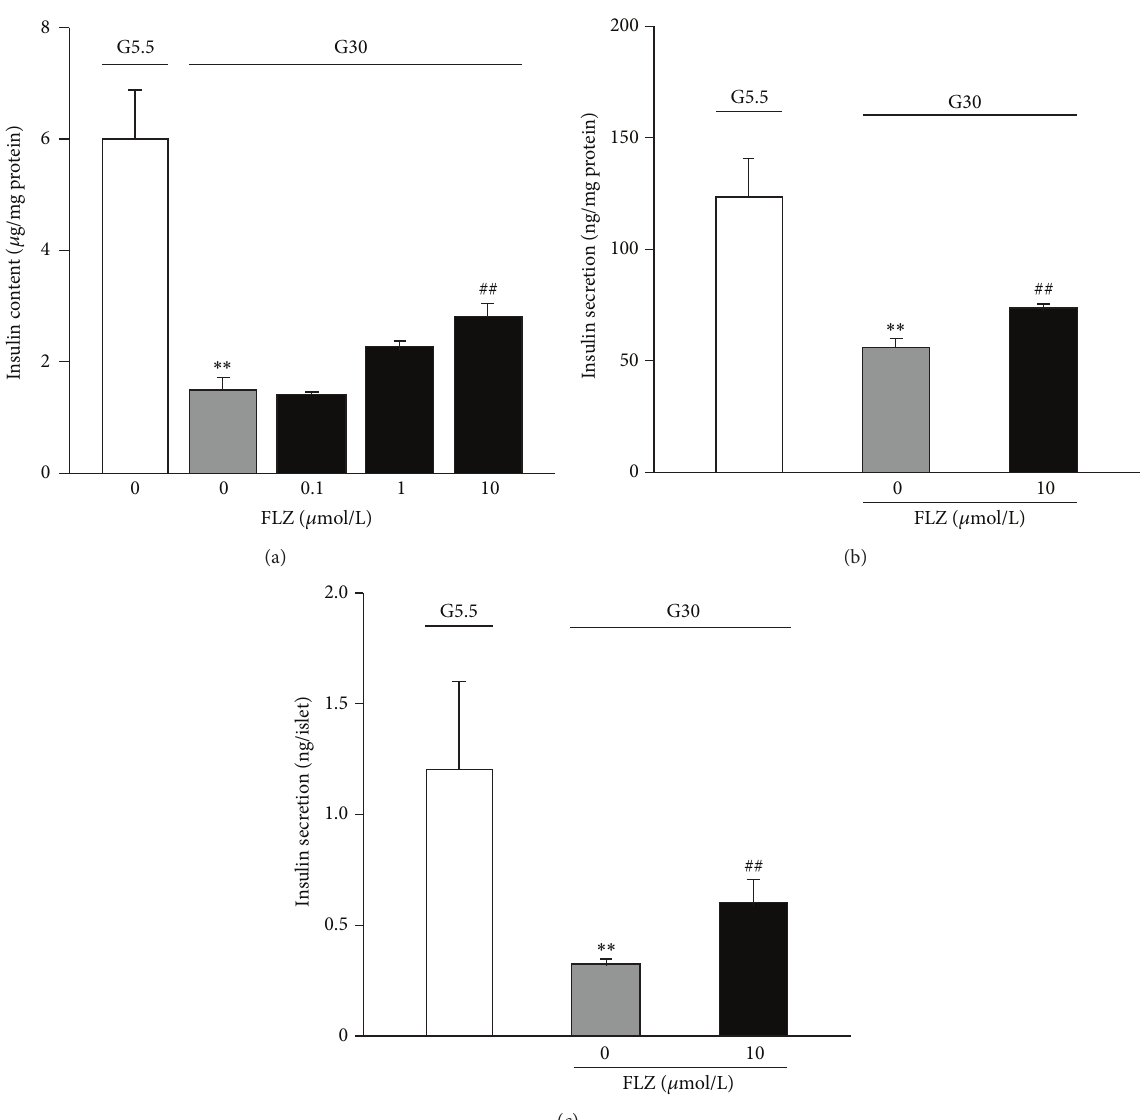
Figure 2: Treatment with FLZ increases insulin content and GSIS at glucotoxicity. (a) INS-1E cells were cultured at G5.5 or G30 for 3 days. Insulin content was assayed without or with varying level of FLZ. Values are normalized against total protein. Data are means ± S.E.M. of 5–8 experiments for each group. ∗∗ 𝑝 < 0.01 versus the value at G5.5; ## 𝑝 < 0.01 versus the value at G30 without FLZ. ((b), (c)) Insulin secretion in INS-1E cells (b) or mouse islets (c) cultured at G5.5 (white bar) or G30 (grey bar) with or without 10 𝜇 M FLZ (black bar) for 3 days. After preincubation with 1 mL KRB buffer for 1h, the cells were stimulated with 1mL KRB buffer containing 16.8 mM glucose for 30min. The supernatants were collected for measurement of secretory insulin. Values were normalized against total protein (b) or the amount of insulin secretion per islet (c); data are means ± S.E.M. of 7–11 (b) or of 5–8 experiments (c). ∗∗ 𝑝 < 0.01 versus the value at G5.5; ## 𝑝 < 0.01 versus the value at G30 without